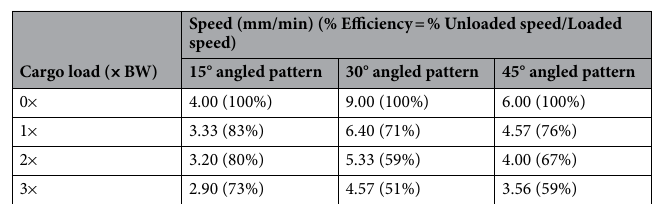
Table 2. Speed of mag-bots under various loading conditions using an induction current of 8.2